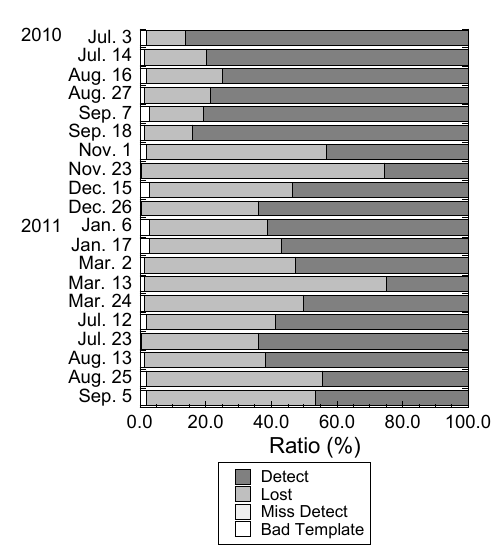
Figure 6. The composition of 4 classification categories; “Detect”, “Lost”, “Miss Detect” and “Bad Template”, for each pair of TerraSAR-X image. Vertical axis is the acquisition date of the slave images